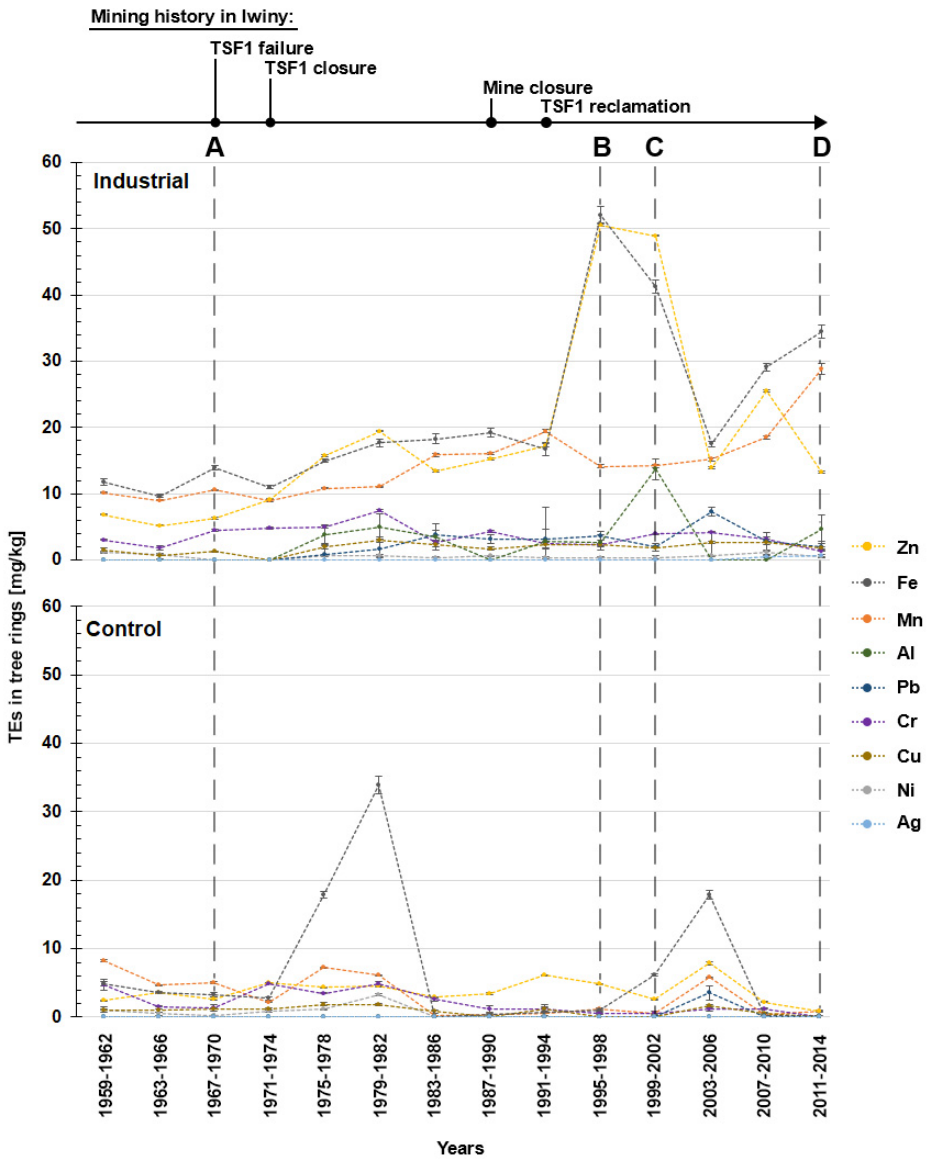
Figure 3. Historical variations of selected trace elements (TEs) in the tree rings of pedunculate oak in different study sites (Control vs. Industerial (Ind.)) between 1959 and 2014. Vertical dashed lines indicate the time intervals (A–D) that have been selected for verification by inductively coupled plasma mass spectrometry (ICP ‐ MS).